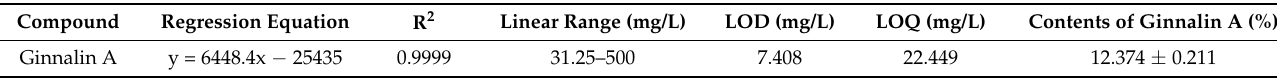
Table 2. The regression equation, limit of detection (LOD), limit of quantification (LOQ), and quantification result of ginnalin A. In the regression equation, y represents the area of the ginnalin peak in the chromatogram monitored at 270 nm of the UV/Vis detector, and the x-axis unit is mg/L.